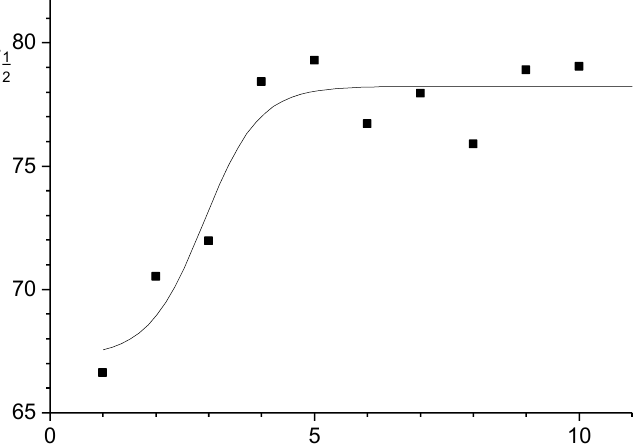
Figure 6. The dependence of the half- width of the absorption band stretching vibrations ν(PO) and ν(PN) in the IR spectra on the generation number G’ n